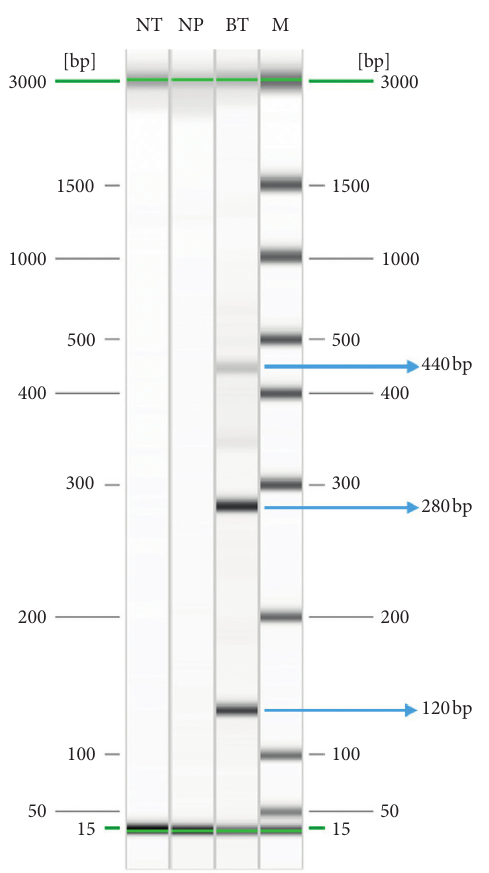
Figure 3: Amplicons from Taenia solium -specific PCR (pTsol9 repeat element) after capillary electrophoresis. Lanes NT, NP, and M represent no template, negative patient, DNA size marker. Lane BT represents brain tissue and shows multiple bands of ≈ 120bp, 280bp, and 440bp, corresponding to the amplification of 1, 2, and 3 repeat unit(s) of the pTsol9 element,